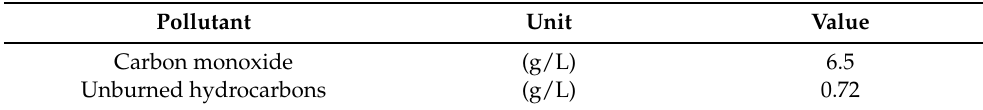
Table 1. Emissions